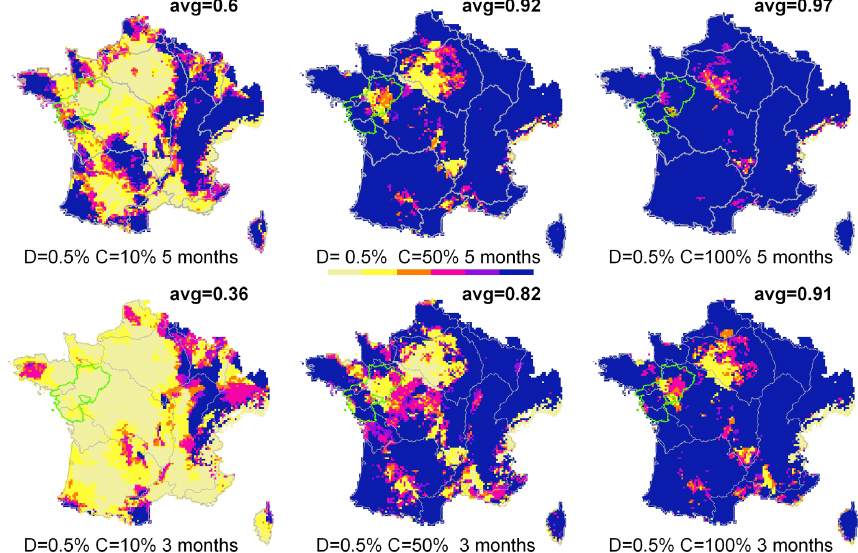
Figure 10. Mean maximum storage fraction of the dams over the dry year of 1991–1992 for 5-month (top) and 3-month (bottom) filling periods. The Pays de la Loire region and the Layon Basin are outlined in